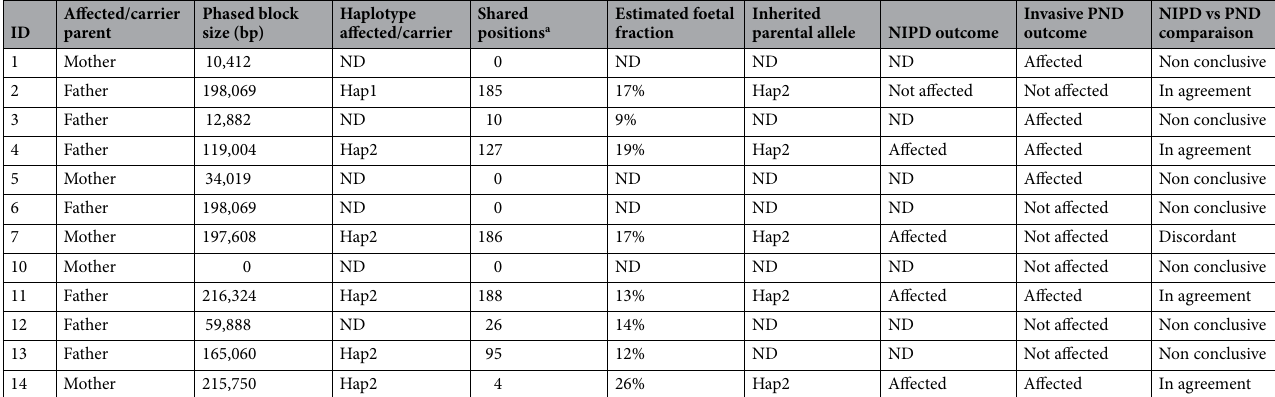
Table 2. Results of the bioinformatic analysis with the deduced NIPD genotypes. a Number of